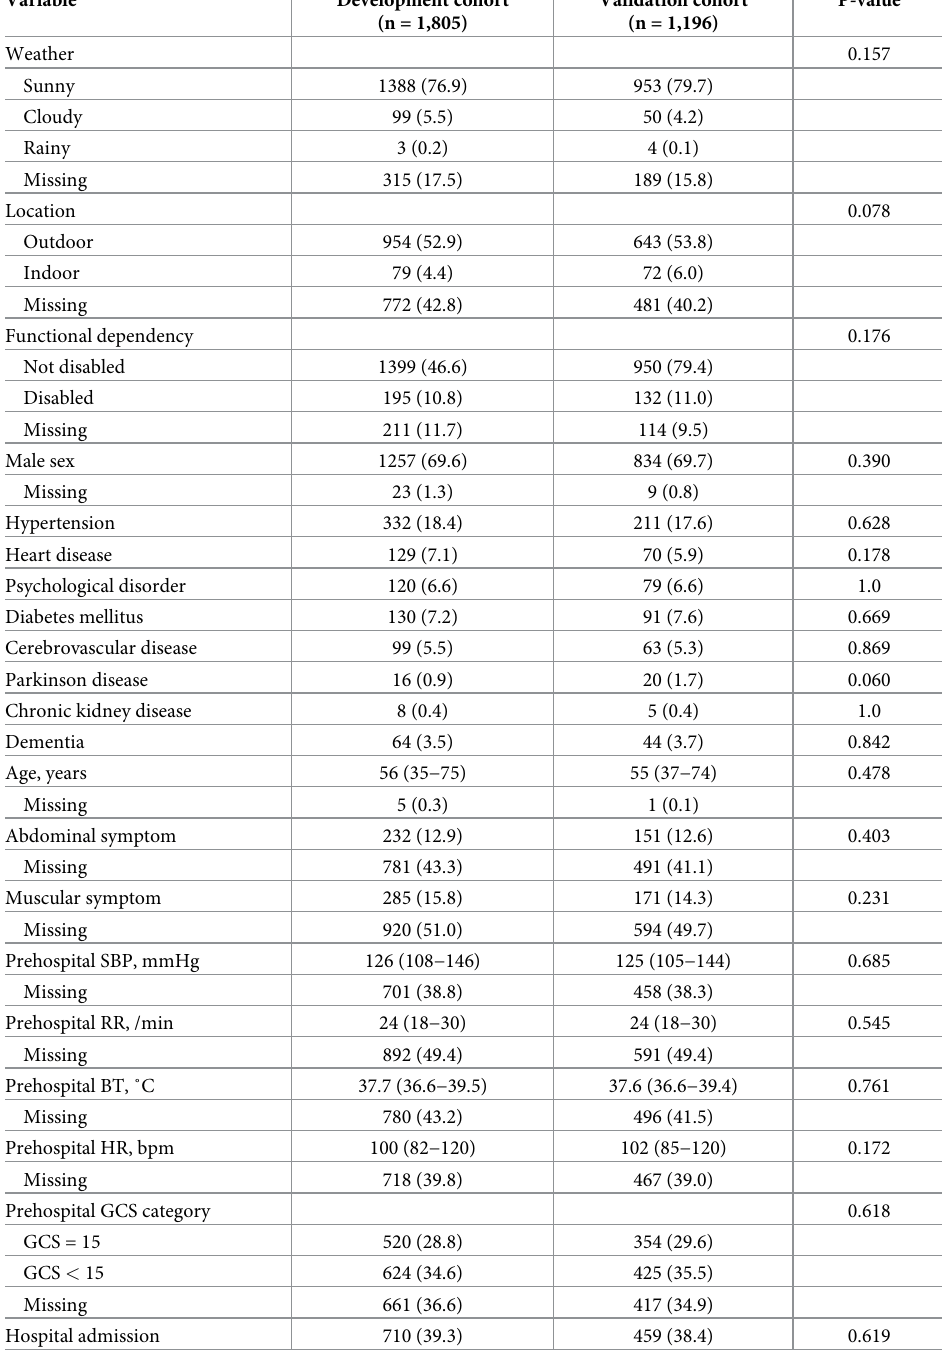
Table 1. Heat-related illness patients’ demographics, prehospital findings, and event characteristics between development and validation